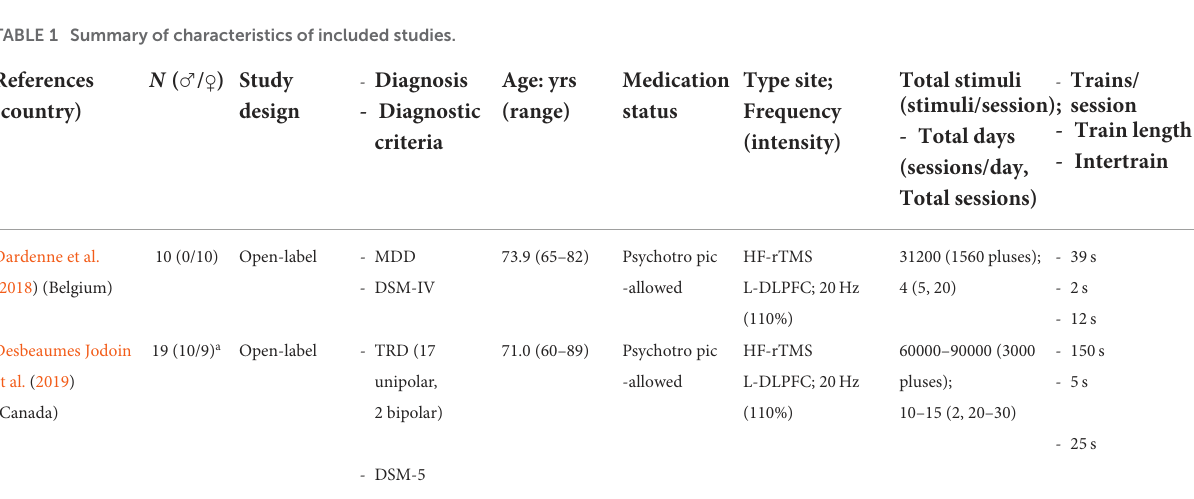
TABLE 1 Summary of characteristics of included